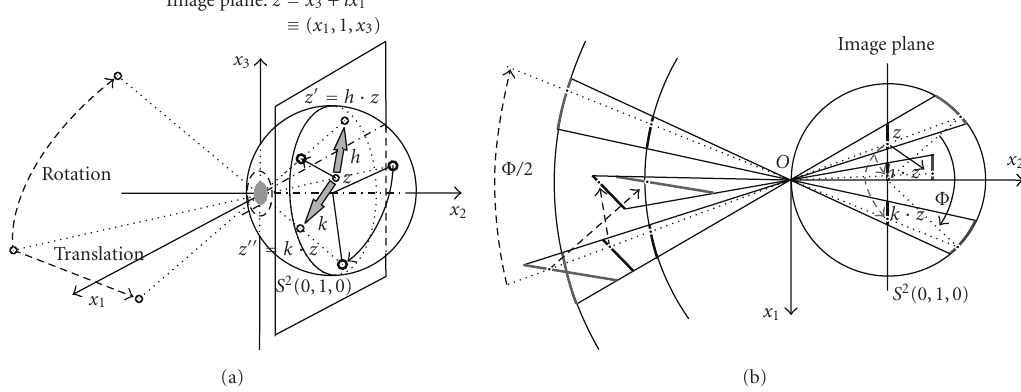
Figure 3: The conformal camera. (a) Image projective transformations are generated by iterations of transformations covering translations “ h ” and rotations “ k ” of planar objects in the scene. (b) The 2D section of the conformal camera further explains how image projective transformations are generated and how the projective degrees of freedom are reduced in the camera; one image projective transformation in the conformal camera corresponds to di ff erent planar objects translations and rotations in the 3D